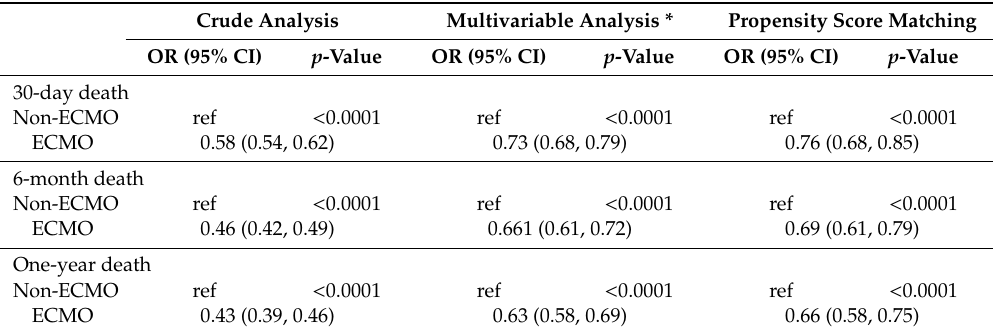
Table 4. Adjusted odds ratio of ECMO support for 30-days, 6-months, one- year mortality after propensity score matching.